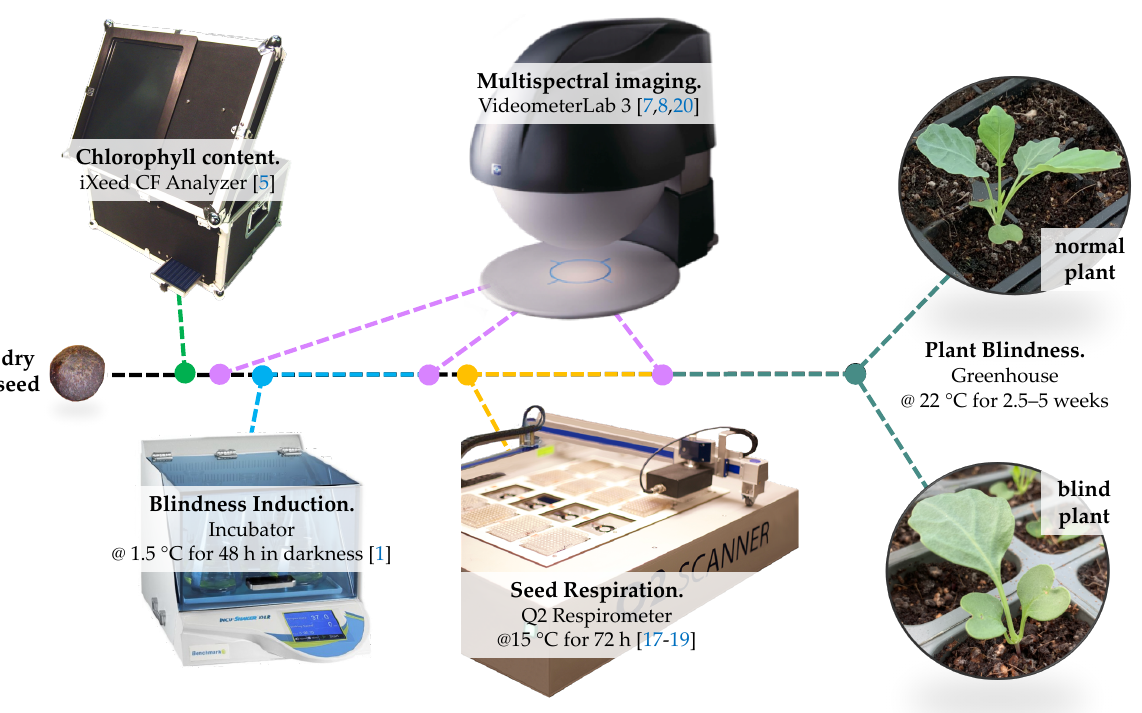
Figure 1. Visual workflow for every seed measured in the study. Starting with chlorophyll content and multispectral imaging taken of the dry seeds (left), followed by the blindness induction treatment, additional multispectral imaging, then seed respiration measurements, additional multispectral data collection and finally seeds were transferred to the greenhouse for growth and plant blindness